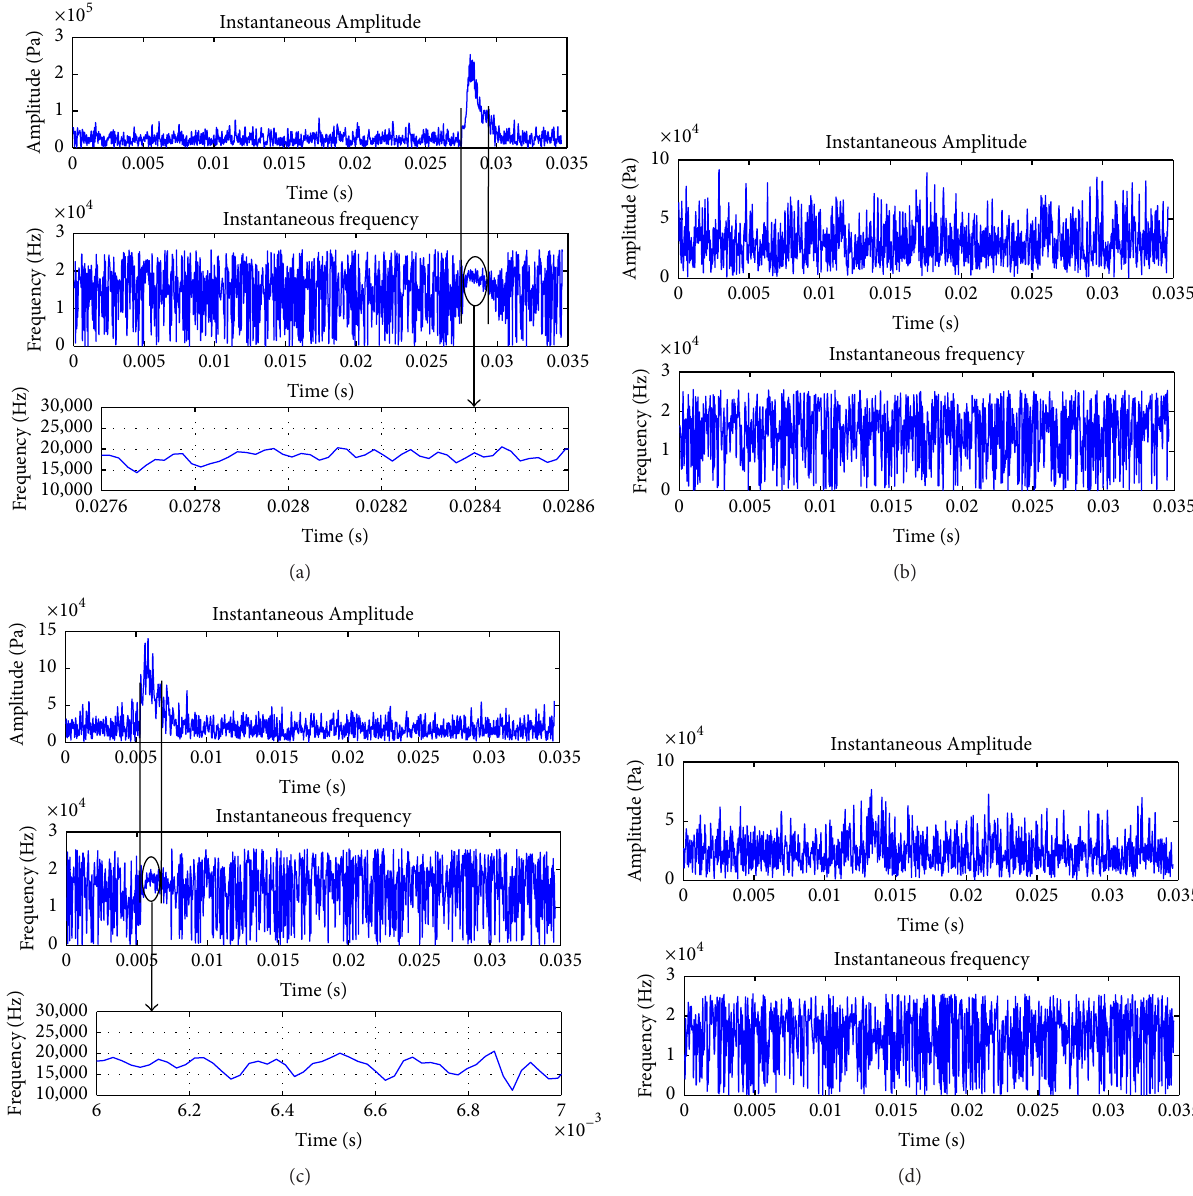
Figure 16: (a) Hilbert transform results of IMF1 for cylinder pressure signal of cylinder 1. (b) Hilbert transform results of IMF1 for cylinder pressure signal of cylinder 2. (c) Hilbert transform results of IMF1 for cylinder pressure signal of cylinder 3. (d) Hilbert transform results of IMF1 for cylinder pressure signal of cylinder